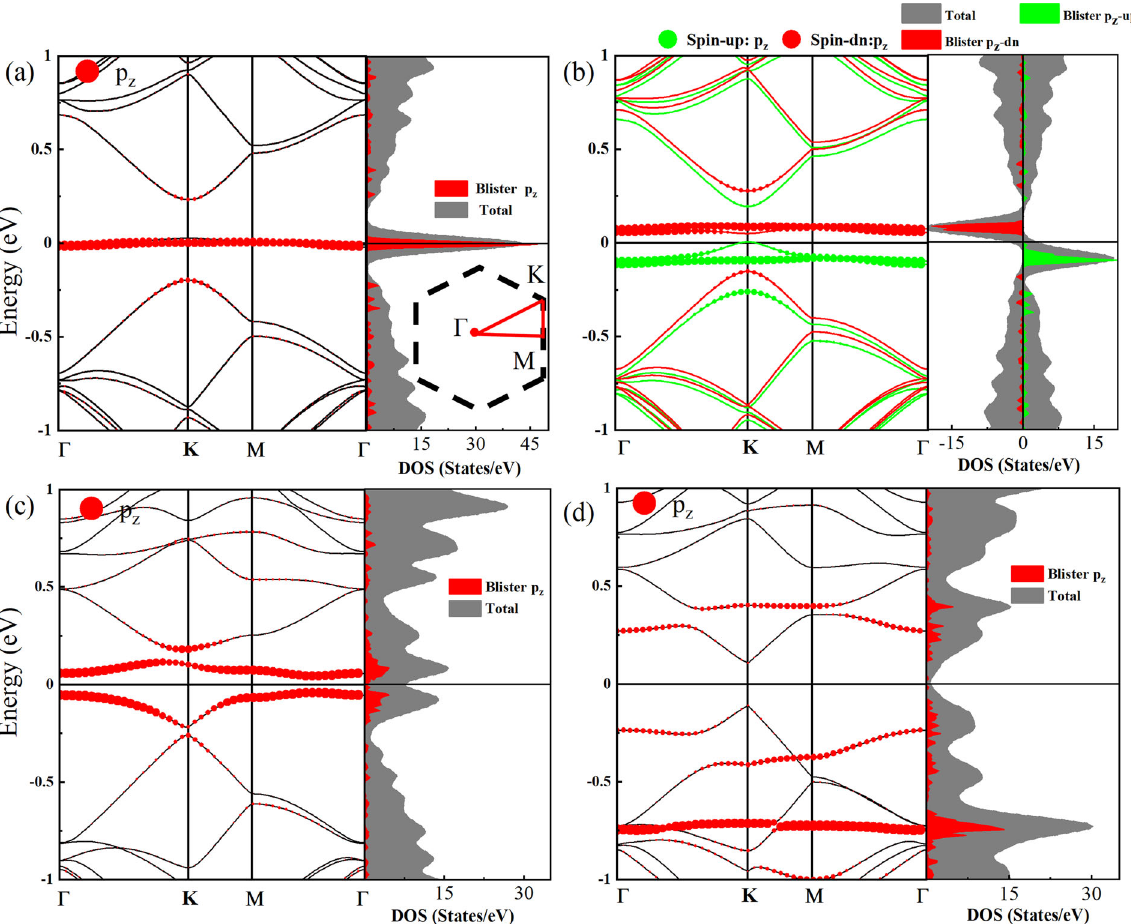
Fig. 2 Projected band structures and corresponding DOS showing Van Hove singularities. a C 2 nonmagnetic case, the red color representing the contribution from the p z orbitals of the blister atoms; b spin-polarized case of C 2 , the green and red color representing the up and down spin; c , d are for the ground state of C 4 and C 6 , respectively; The size of the circles represents the relative weights of the p z orbitals of the blister